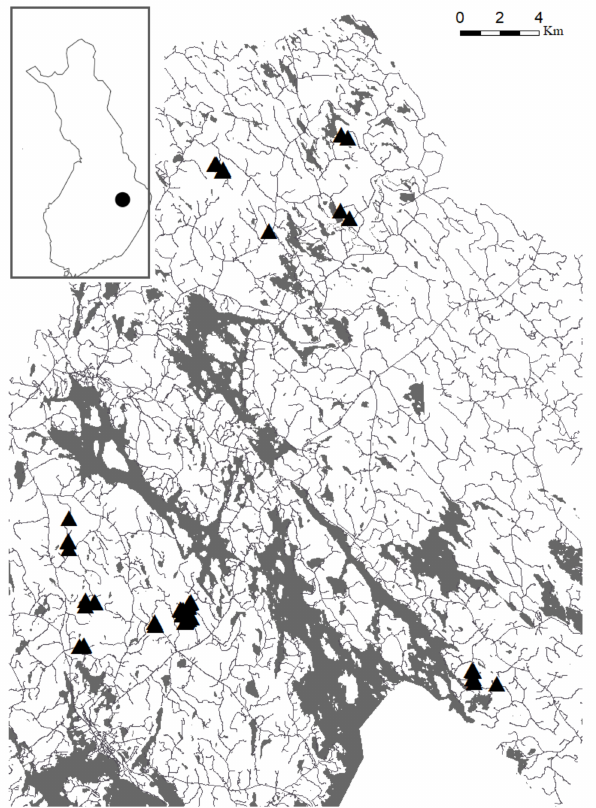
Figure 1. The distribution of field plots on forest roads in Tuusniemi, Finland. The water surfaces are marked in gray; n =